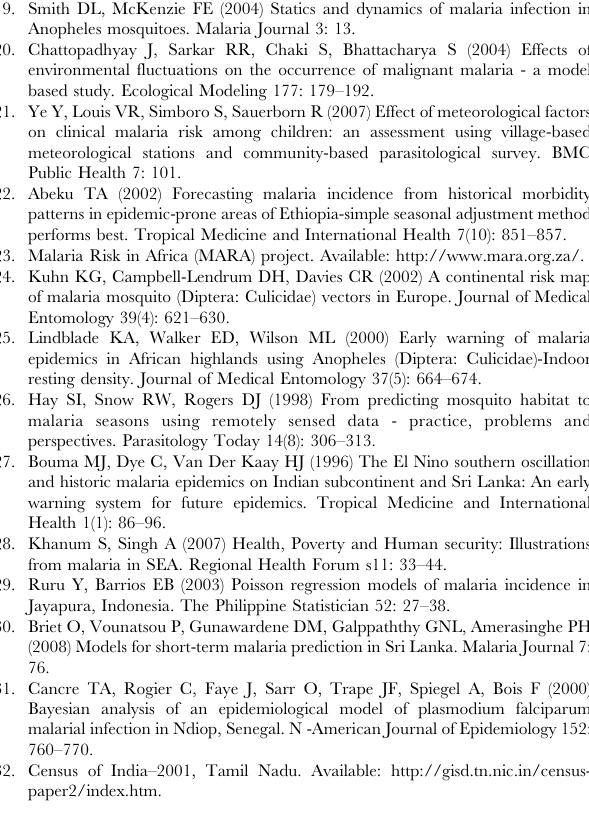
Figure S6 Scree plot showing the number of factors to be retained. Figure S7 Residual plots of clusters: (a) Cluster-I, (b) Cluster-II, (c) Cluster-III, (d) Cluster-IV, (e) Cluster-V. Found at: doi:10.1371/journal.pone.0004726.s008 (4.28 MB TIF) Table S1 Refinement of model through multi step variable induction and improvement of R 2 .